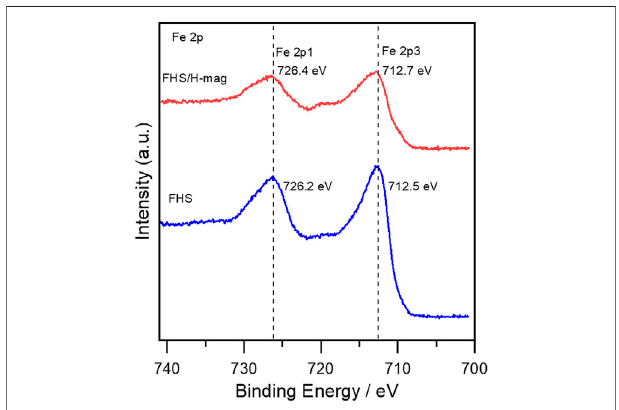
FIGURE8| Crystalstructureofhydroniumjarositeshowinganexampleof Fe(III) cites in FHS that can interact with the surface of H-mag. Color coding: pink (cid:2) H, red (cid:2) O, yellow (cid:2) S, brown (cid:2) Fe.